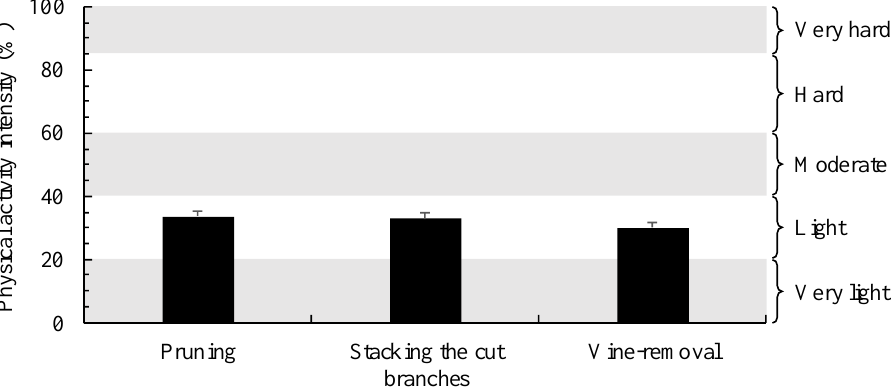
Figure 5. Comparison of the PAI of each FCA. Data are presented as mean ± standard error.